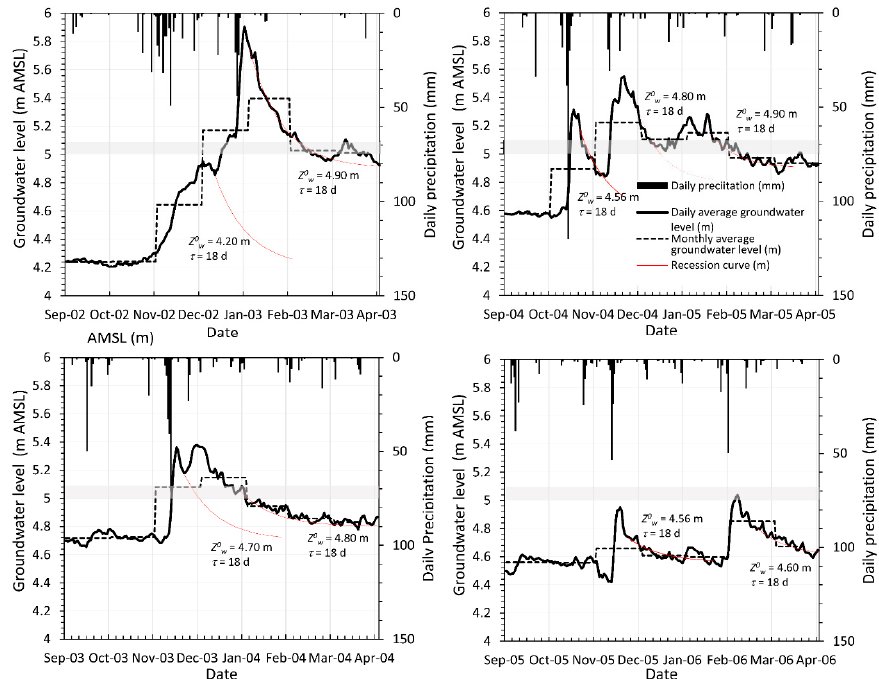
Figure 4. Comparison between daily precipitation (mm), daily average groundwater level (m AMSL), and monthly average groundwater level (m AMSL). Red lines represent the recession curve determined in correspondence with the significant rainfall event. For each recession curve, the recession time τ (d) is indicated, as is the respective value the groundwater level will attain if no episodic recharge occurs 𝑍 (cid:3050)(cid:2868) (m). The grey bar indicates the depth of the bed of the silty and clay unit. Long term lateral recharge combines with direct recharge that takes place along the vadose zone. As shown in Figure 4, the daily groundwater level falling after rising due to significant rainfall events decreases exponentially according to the following recursive expression [37]: